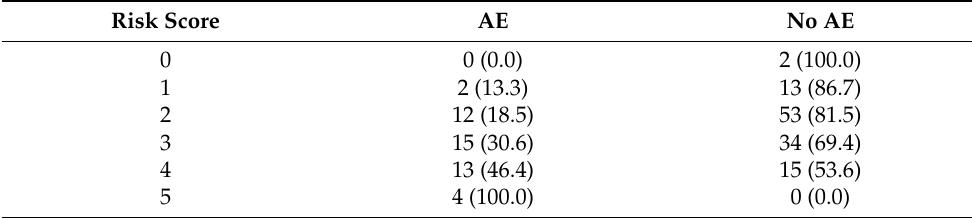
Figure 1. The area under the receiver operating curve for ritodrine-induced adverse events. Based on the multivariable analysis model, we constructed a risk scoring system to predict ritodrine-induced AEs. We assigned one point to each factor: height < 160 cm and number of variant alleles (each from 0 to 2) in rs3730168 and rs1152746. Thus, the total risk score range was 0 to 5. According to the constructed risk scoring system, patients with 0, 1, 2, 3, 4, and 5 points were at 0%, 13%, 19%, 31%, 46%, and 100% risks of developing AEs, respectively (Table 4). The risks predicted using the logistic regression curve are shown in Figure 2; the predicted risks of AEs for patients with 0, 1, 2, 3, 4, and 5 points were 4%, 9%, 18%, 32%, 51%, and 69%, respectively. Table 4. Observed risks of ritodrine-induced adverse events according to risk scores.